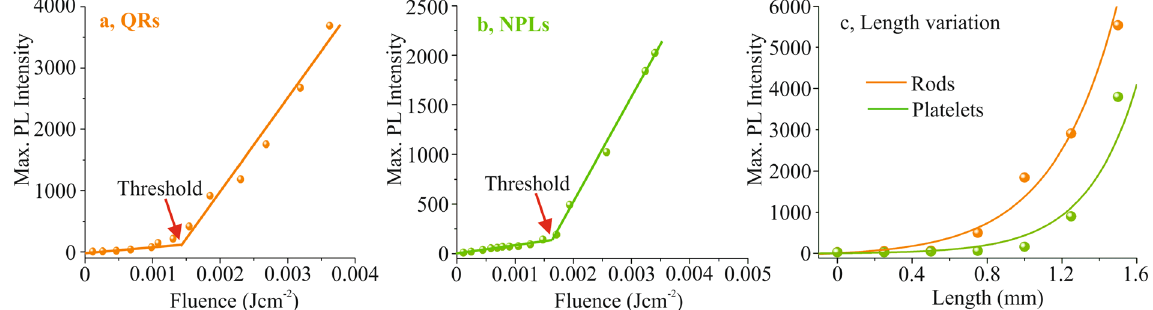
Figure 5. The QRs and NPLs show ASE thresholds at ≈ 1.3 mJ cm − 2 ( a ) and ≈ 1.54 mJ cm − 2 ( b ), respectively. ( c ) Represents the slit variation performance of QRs and NPLs corresponding to the pump pulse energy at the sample to be ≈ 2.25 μ J, with an interaction length of 1.5 mm. The QRs needs 0.5 mm opening of the slit for ASE whereas NPLs needs 0.85